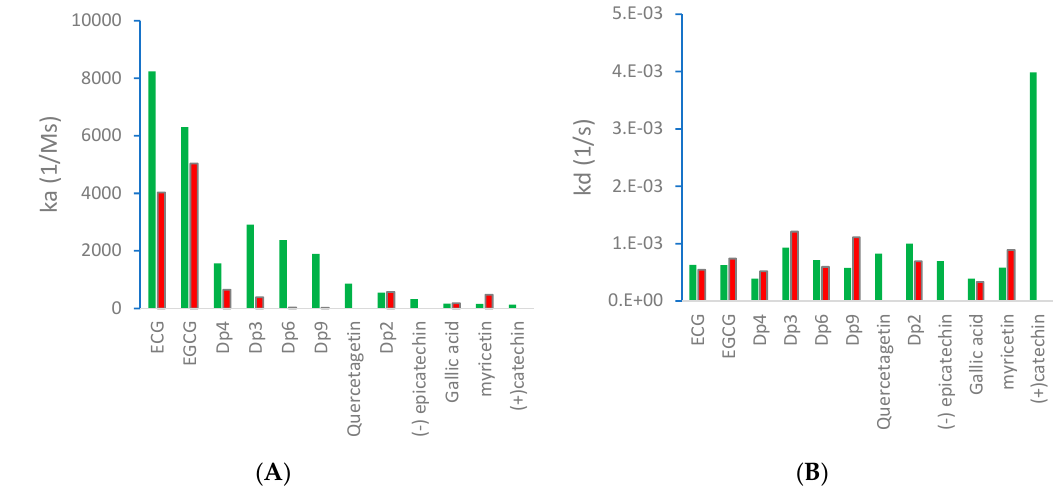
Figure 3. ( A ) Association rate (k a ) and ( B ) dissociation rate (k d ) between polyphenols and VEGF at 20 °C (red) and 37 °C (green).